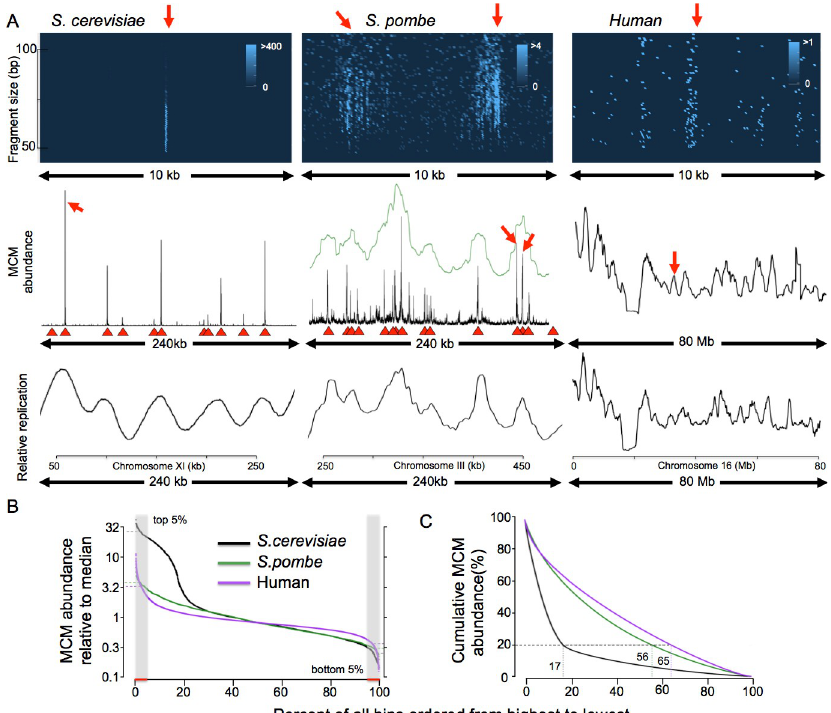
Fig 2. MCM distribution and replication in yeasts and human. (A) 3x3 grid summarizing MCM binding and DNA replication in S . cerevisiae , S . pombe and human (HeLa). Left 3 panels show budding yeast (chr. XI), middle three panels show fission yeast (chr. II) and right 3 panels show HeLa cells (chr. 18). For Mcm2-ChEC experiments (top 2 rows), budding yeast were arrested for 2 hours with alpha factor, log phase fission yeast were transferred to medium containing 15 mM HU for 3 hours, and HeLa cells were arrested with contact inhibition. Top row: Mcm2 binding visualized by plotting chromosomal location on the x axis, fragment size on the y axis, and read depth indicated by color intensity, as described in the text. The budding yeast image corresponds to ARS1103 and the fission yeast to II- 448. Middle row: Mcm2-ChEC read depths of all fragment sizes are plotted across 240 kb (both yeasts) or 80 Mb (HeLa). Green line in the middle plot ( S . pombe ) shows Mcm2-ChEC read depths divided into 1 kb bins and smoothed with a 15 bin sliding window. Red triangles in both yeasts indicate known origins of replication, as listed in oridb.org. Red arrows indicate regions of correspondence between the top and middle rows. Bottom row: Replication as determined by S to G1 ratio of flow sorted cells for budding and fission yeast, and by BrdU incorporation for HeLa. (B) MCM distribution expressed as fraction of median value for 5 kb-binned Mcm2-ChEC signal. S . cerevisiae , S . pombe , and HeLa are shown in black, green and purple, respectively. For each organism, the ratio of the median value in the 5% of bins with the highest MCM abundance (hatched region on left) to that in 5% of bins with the lowest abundance (hatched region on right) provides a metric for the degree of MCM dispersion in each organism. (C) Cumulative distribution of 5 kb-binned Mcm2-ChEC signal of all fragment sizes in S . cerevisiae , S . pombe and HeLa. The highly focused MCM signal in S . cerevisiae , as opposed to S . pombe and humans, is clear based on the observation that 80% of the S . cerevisiae signal is concentrated in just 17% of the genomic bins, whereas 56% and 65% of the bins were required to capture the same fraction of total signal in S . pombe and humans, respectively.